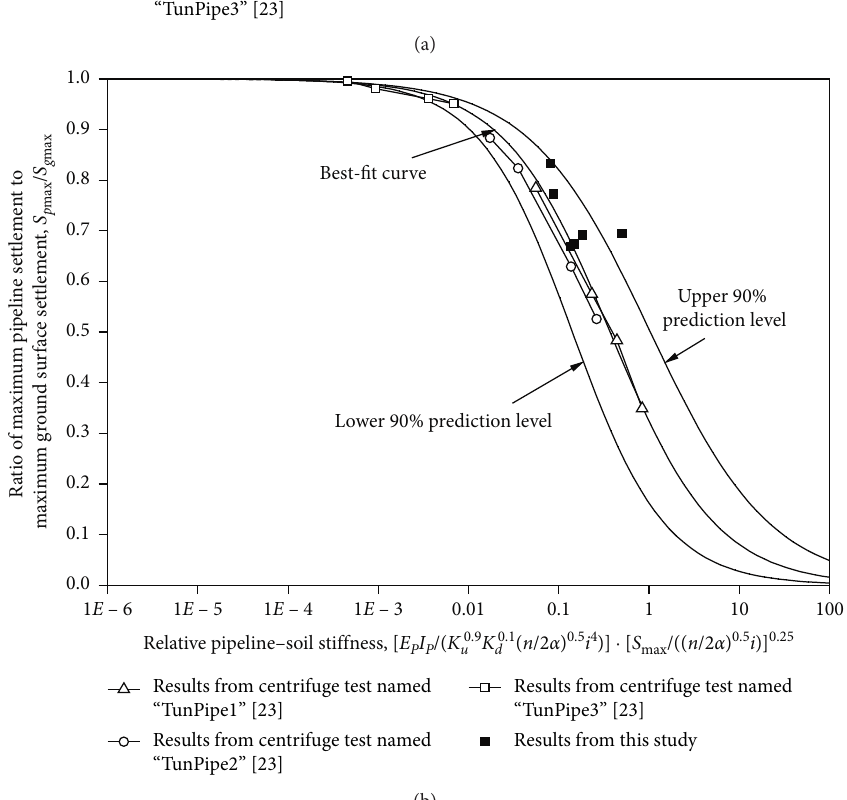
Figure 10: Comparison of calculation results with field and centrifuge test results: (a) relative pipeline-soil stiffness and ratio of maximum pipe curvature to maximum ground curvature; (b) relative pipeline-soil stiffness and ratio of maximum pipeline settlement to maximum ground